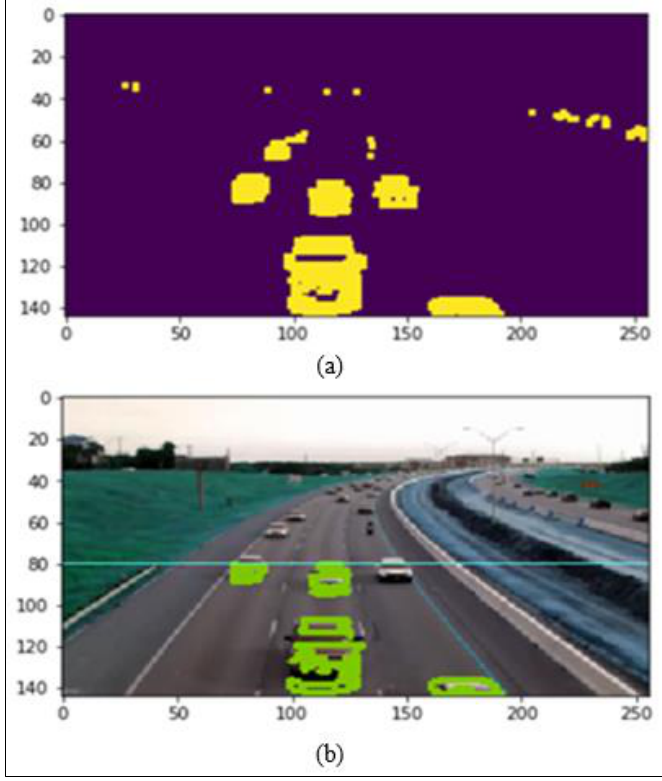
Figure 5: Moving vehicle detection (a) Finding vehicle zone (b) Detect vehicles. Source: Authors, (2020).